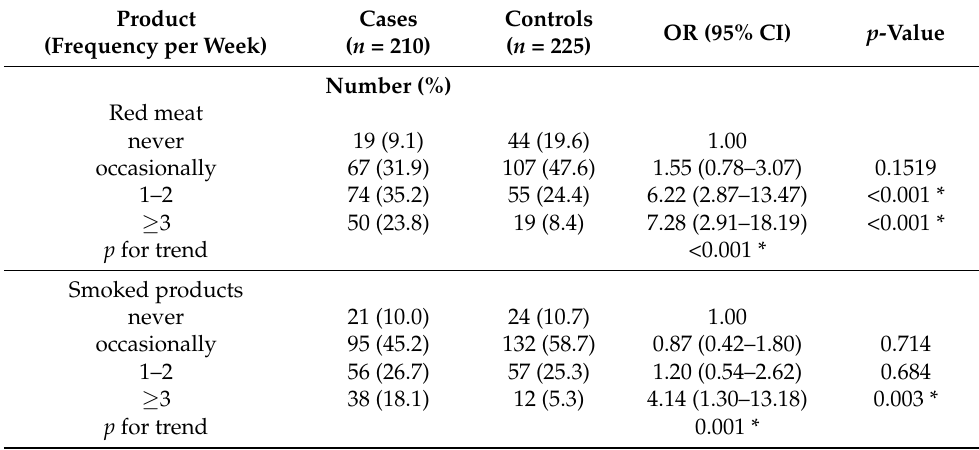
Table 2. Association between dietary components and risk of breast cancer in postmenopausal